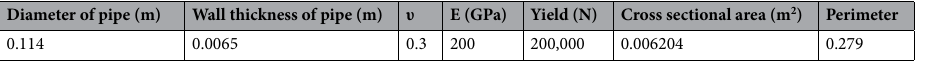
Table 11. Parameters used for umbrellas.